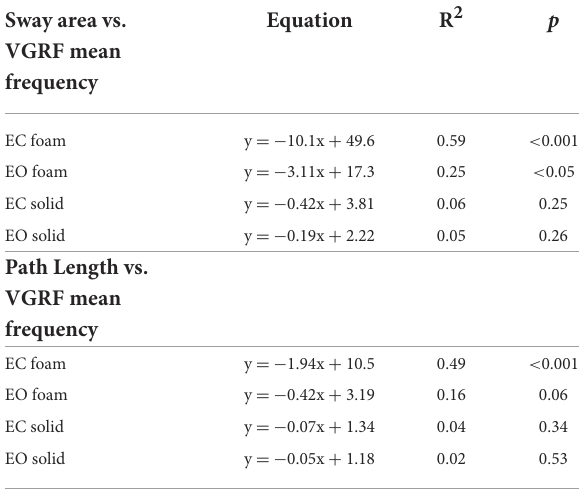
TABLE 3 Equations of the lines fitting the values of Sway Area and Path Length versus VGRF Mean frequency in the four standing conditions. Sway area